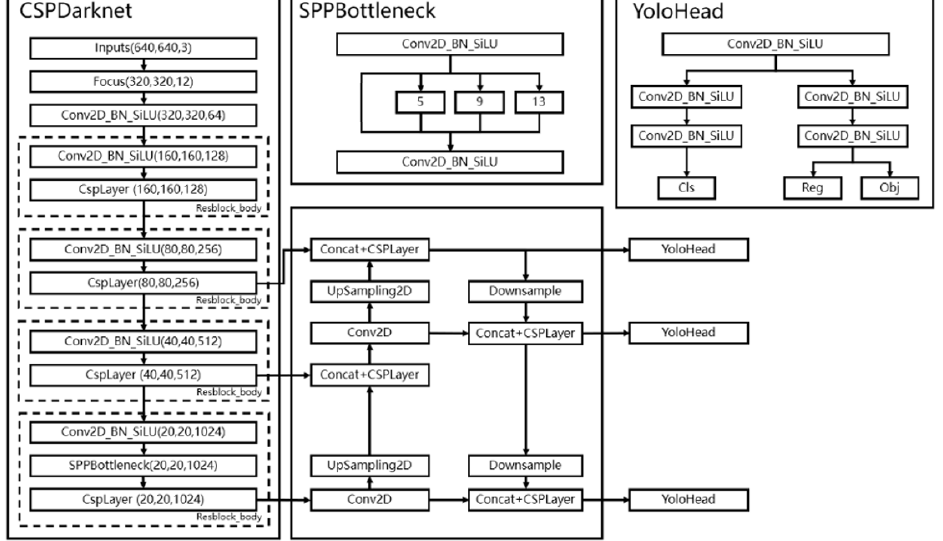
Figure 1. The structure of